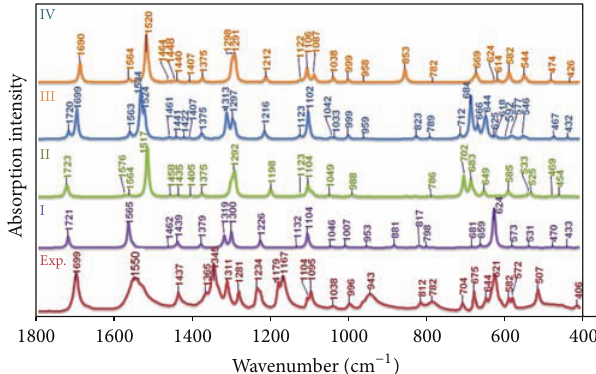
Figure 8: Experimental FT-IR (solid) and calculated (scaled) absorption intensity spectra of acetazolamide dimer (I–IV) in the region 1800–400 cm −1 ,